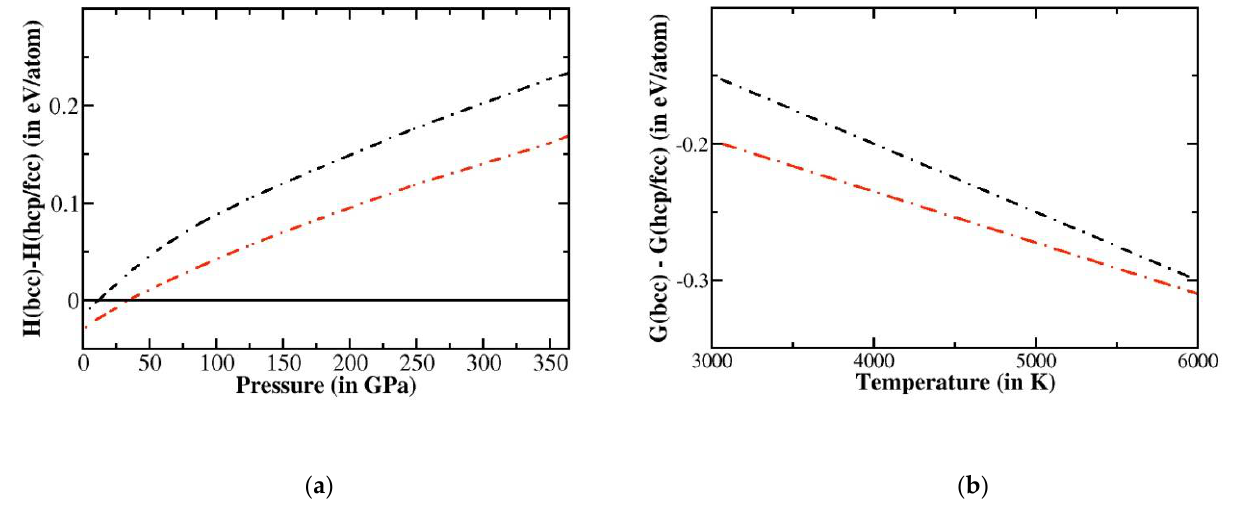
Figure 3. ( a ) Enthalpy of hexagonal closed packed (hcp)-Fe [H(hcp)] and face-centered cubic (fcc)-Fe [H(fcc)] with respect to bcc-Fe [H(bcc)] plotted as a function of pressure in the presence of 6.25% Ni doping. Black dashed line: H(bcc)-H(hcp). Red dashed line: H(bcc)-H(fcc). ( b ) Gibbs energy of hcp-Fe [G(hcp)] and fcc-Fe [G(fcc)] with respect to bcc-Fe [G(bcc)], plotted as a function of temperature. Black dashed line: G(bcc)-G(hcp). Red dashed line: